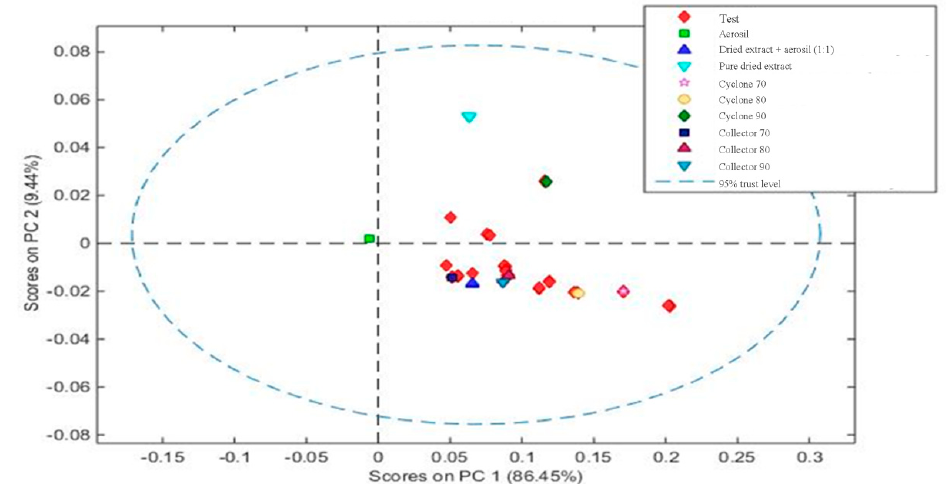
Figure 6. Principal component analysis showing the distribution of the samples based on the mixtures of dried extract/excipient and the extracts obtained in different parts of equipment (collector or